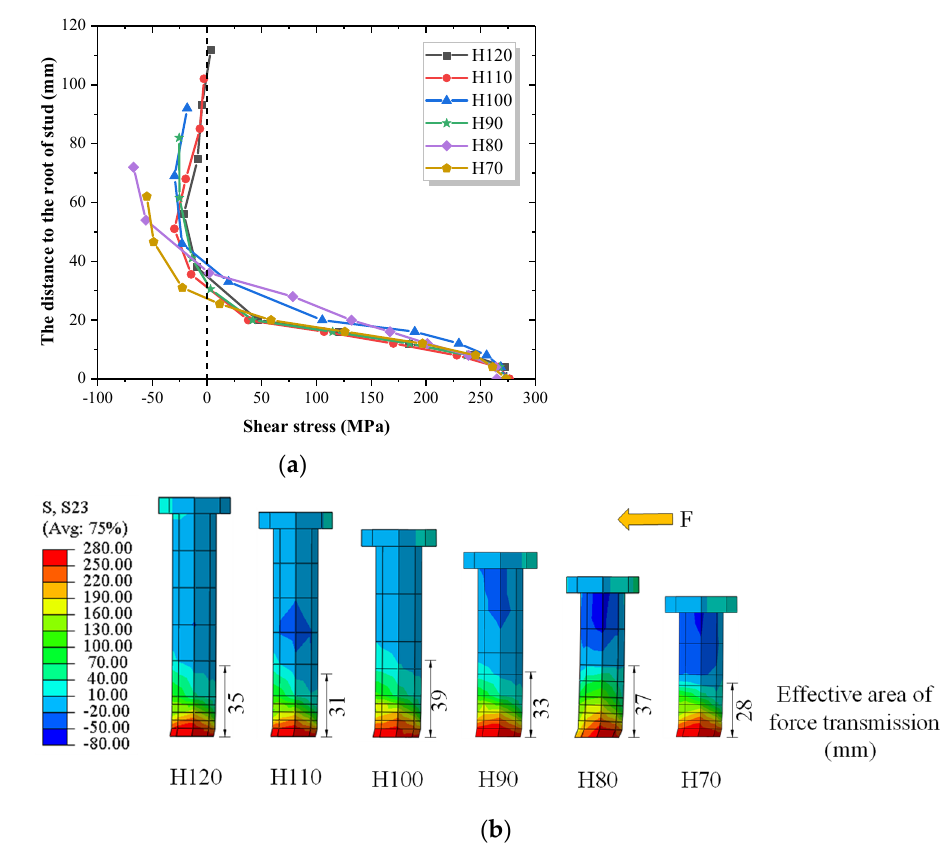
Figure 22. Shear stress distribution along with the height of the studs: ( a ) curves of shear stress; ( b ) contour plots of shear stress.